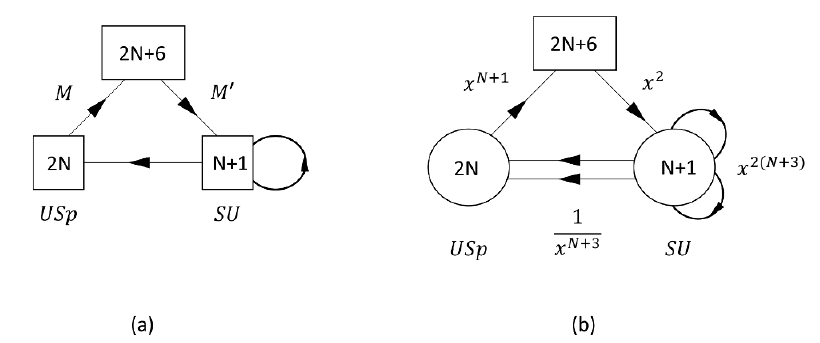
Figure 4. 4 d theories corresponding to compacti(cid:12)cations with (cid:13)ux preserving SU(2 N + 6). Figure (a) shows the theory associated with a sphere with two punctures and (cid:13)ux 1 , while (b) shows 4 the theory associated with a torus and (cid:13)ux 1 . The arrow from the SU group to itself stands 2 for an antisymmetric chiral (cid:12)eld. There are cubic superpotentials for every triangle and for every antisymmetric chiral coupling it to two bifundamentals. The theory has an U(1) x SU(2 N + 6) (cid:2) global symmetry as well as a U(1) R symmetry. For the U(1) R it is convenient to use the 6 d R- symmetry under which the bifundamentals have charge 0, the antisymmetrics have charge 2, and all the others have charge 1. The charges under U(1) x are shown using